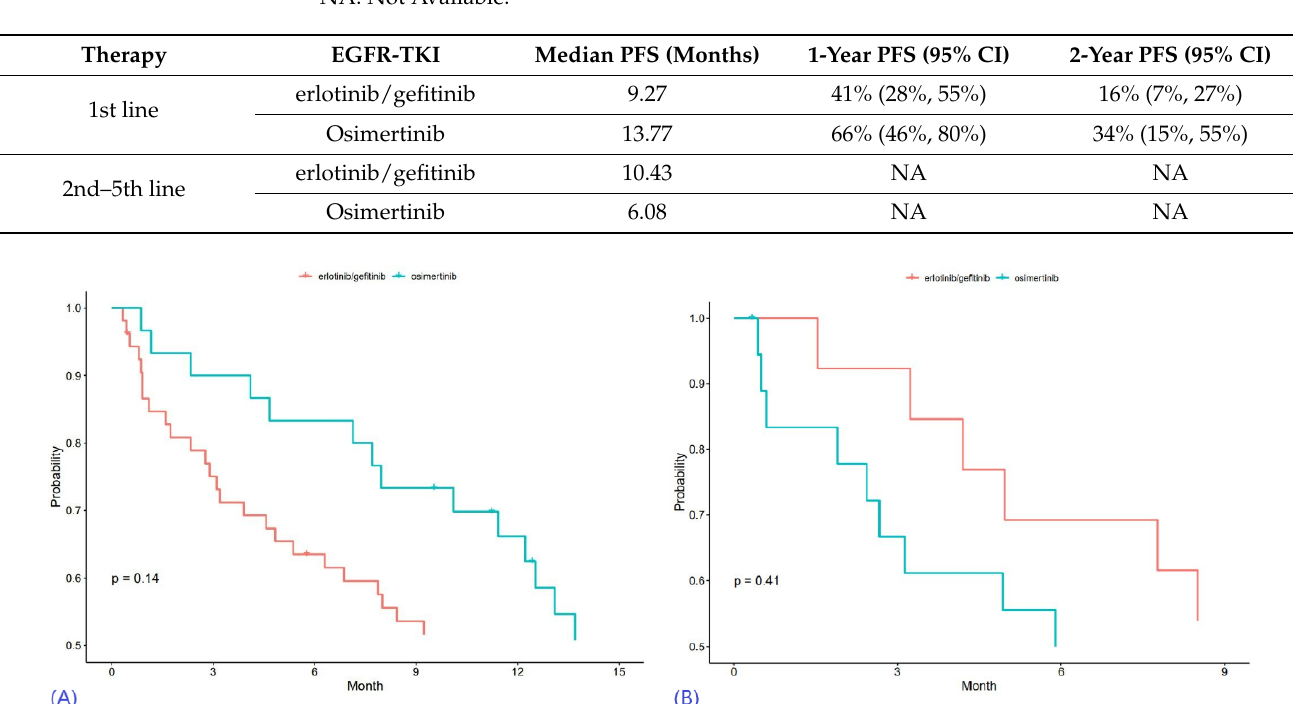
Table 8. Unadjusted Progression-free survival (PFS) of patients with NSCLC brain metastases treated with first-generation and third-generation EGFR Tyrosine Kinase Inhibitors (EGFR-TKIs). NA: Not Available.